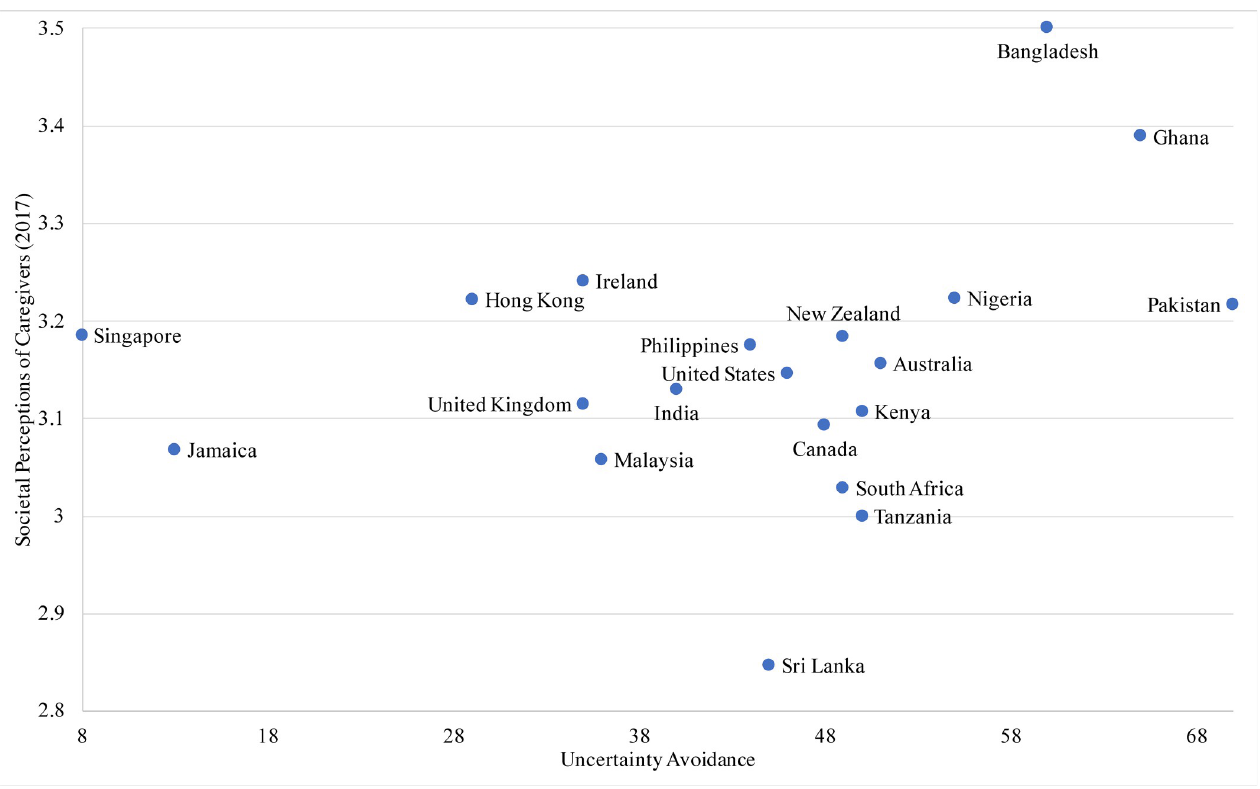
Fig 2. Scatterplot of societal perceptions of caregiving and uncertainty avoidance across 20